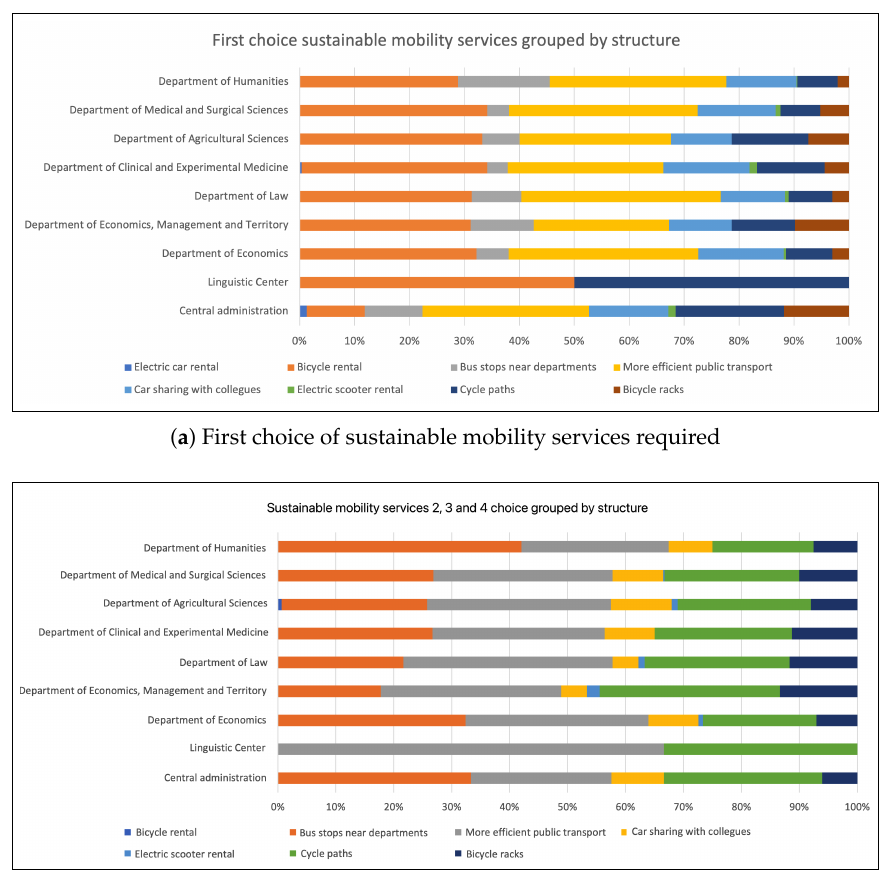
Figure 22. Sustainable mobility services required by Department.